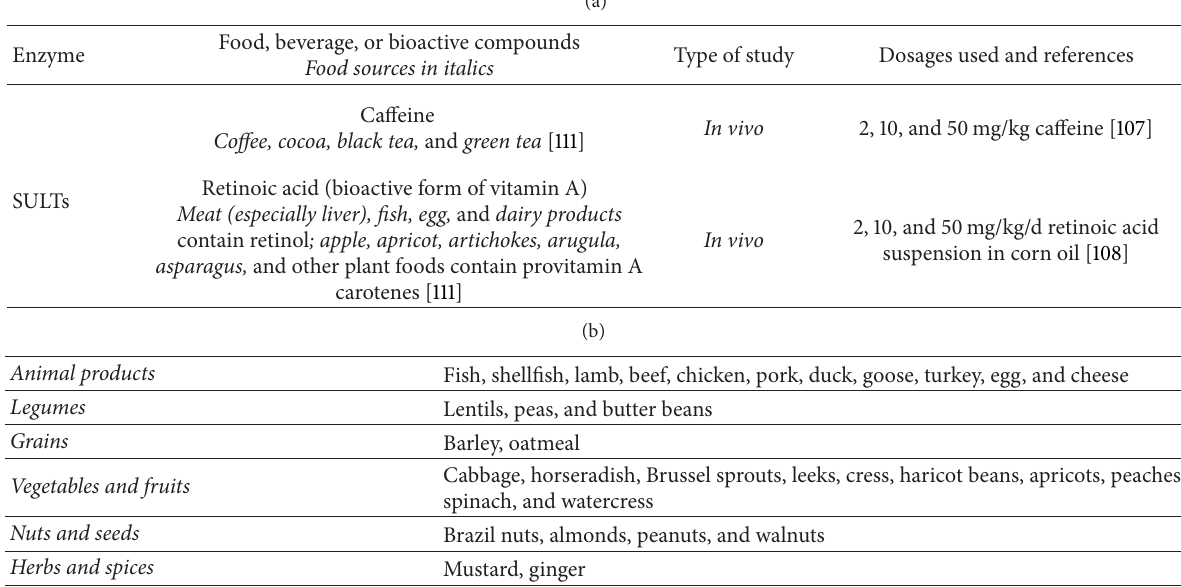
Table 6: (a) In vivo example nutrient inducers of sulfotransferases (SULTs). (b) Selected dietary sources of sulfur-containing compounds (adapted from